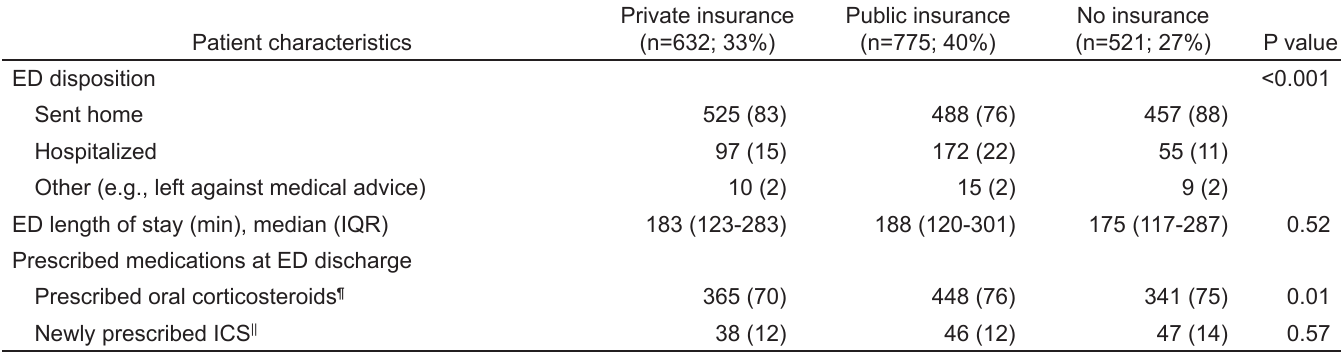
Table 1. Patient characteristics and emergency department course, according to primary insurance